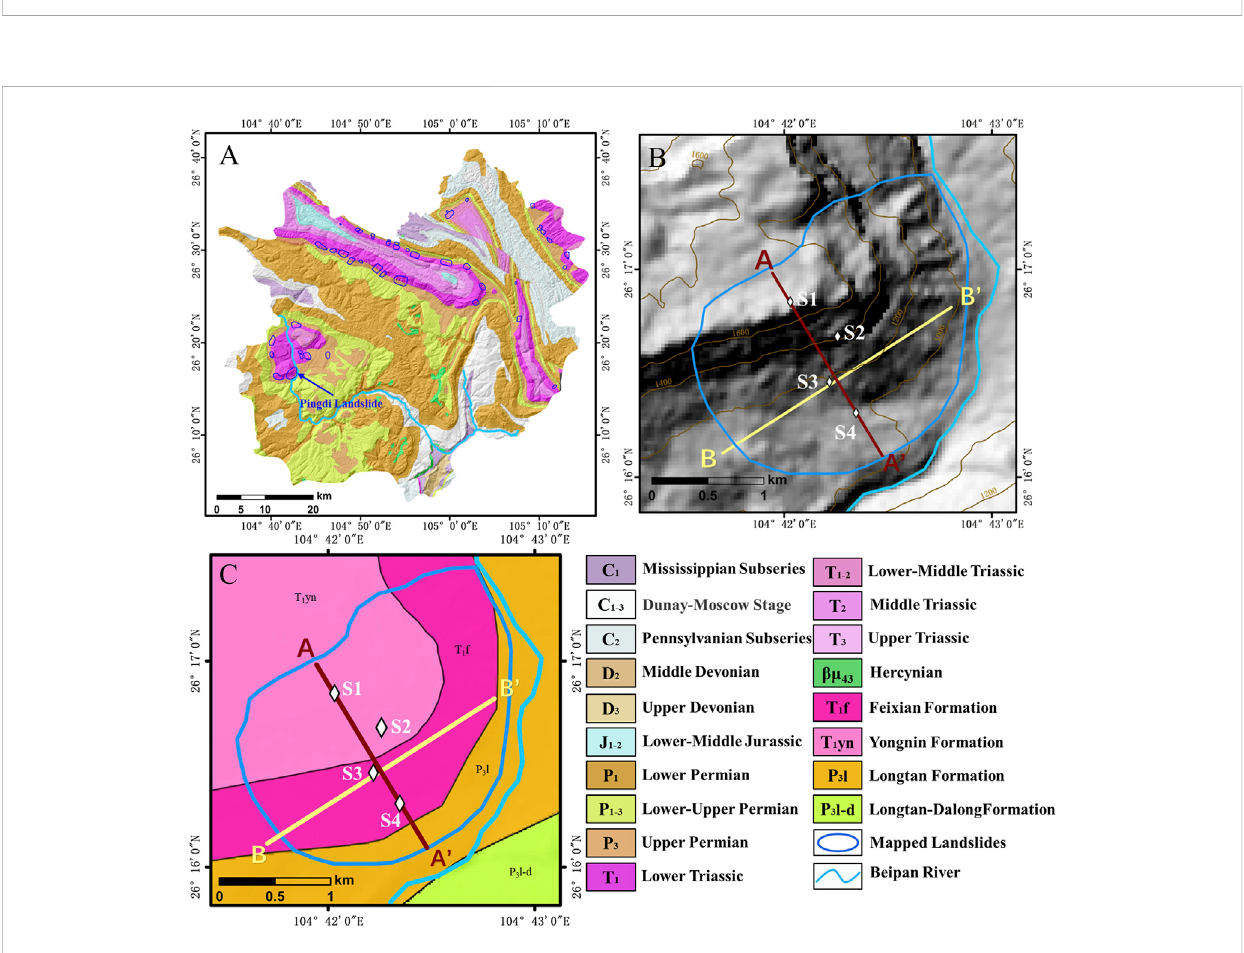
FIGURE 2 (A) Geological settings of the study area, with ascale of 1:250,000, where detected landslides are shown in blue circles. (B) Shaded relief map of the Pingdi landslide, labeled as No.39 in Figure 4D, where two pro fi les are shown as AA ’ and BB ’ , respectively, and four feature points are labelled. (C) Geological map of the Pingdi landslide with scale of